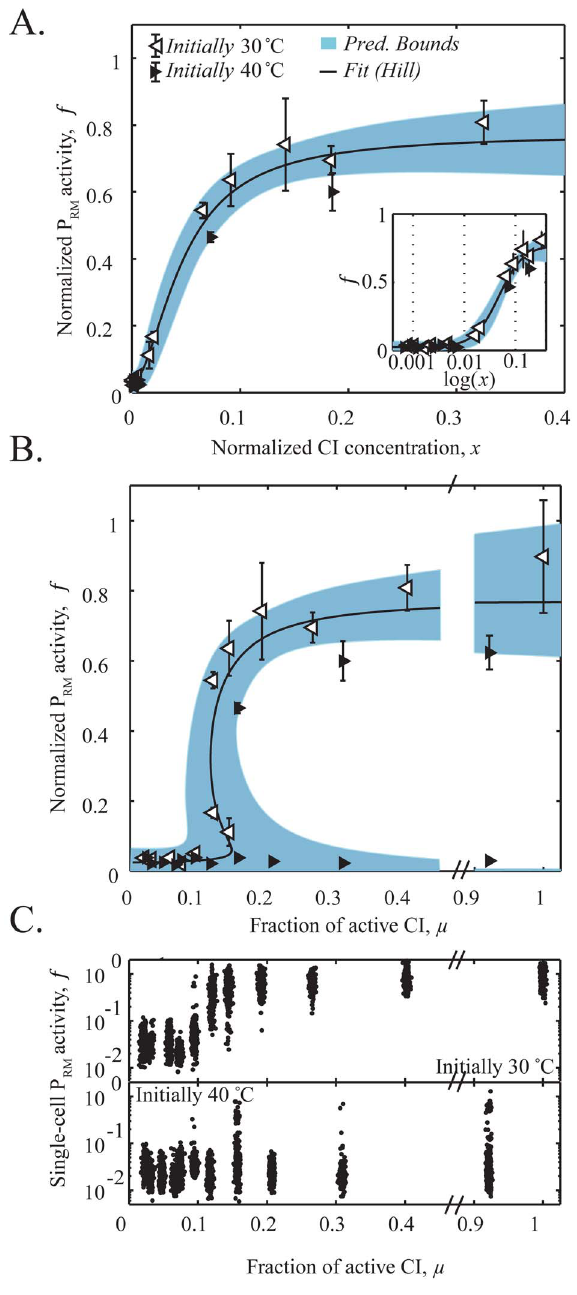
Figure 2. Experimental demonstration of bistability and hysteresis. ( A ) P RM promoter activity as a function of CI concentration in the cell. Both observables were measured as described in the main text, and are normalized by the mean promoter activity of the initial lysogenic state (at 30 u C). Black and white triangles represent data from cells initially grown in the lytic (40 u C) and lysogenic (30 u C) states, respectively. Each data point was obtained by averaging over three independent experiments. Error bars represent the standard error of these three experiments. The solid line is a fit to a Hill function and the shaded blue area is the 95% confidence interval of that fit. The inset depicts the same data in semi-logarithmic scale. ( B ) Predicted and measured steady-states of the lysis/lysogeny circuit. Prediction: Solid line, predicted P RM steady states based on the fitted P RM regulatory curve in panel A. Shaded region represents the confidence boundary of the theoretical prediction. Measurement: white and black triangles are the same data set depicted in panel A, plotted with respect to m . ( C